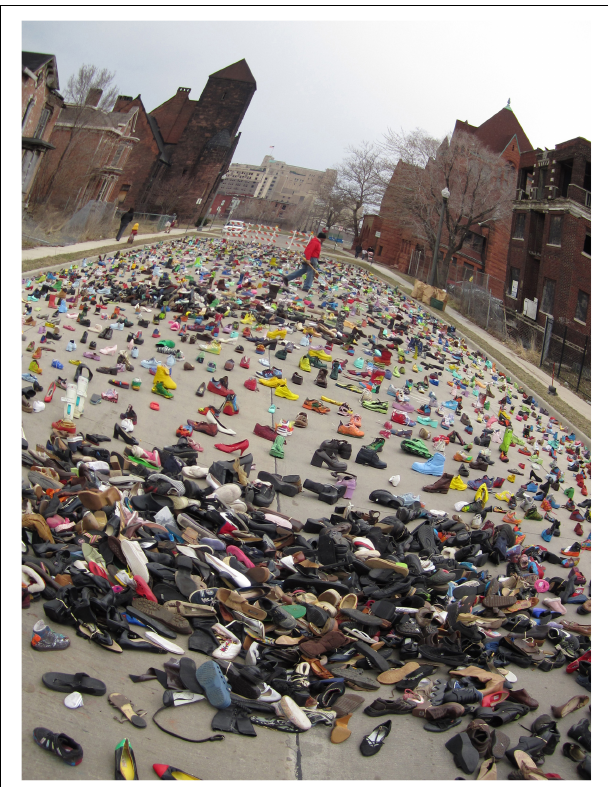
FIGURE 4 | Art Street’s Artist’s exhibit, Streetfolk. Photo: Michelle